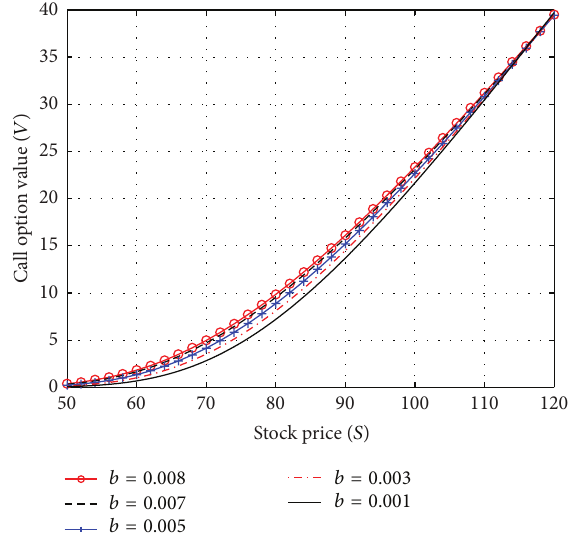
Figure 4: Asian put option pricing corresponding to the different 𝑏